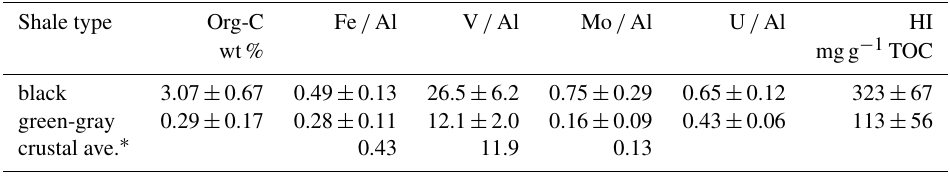
Table 1. Averages for geochemical parameters in outcrop